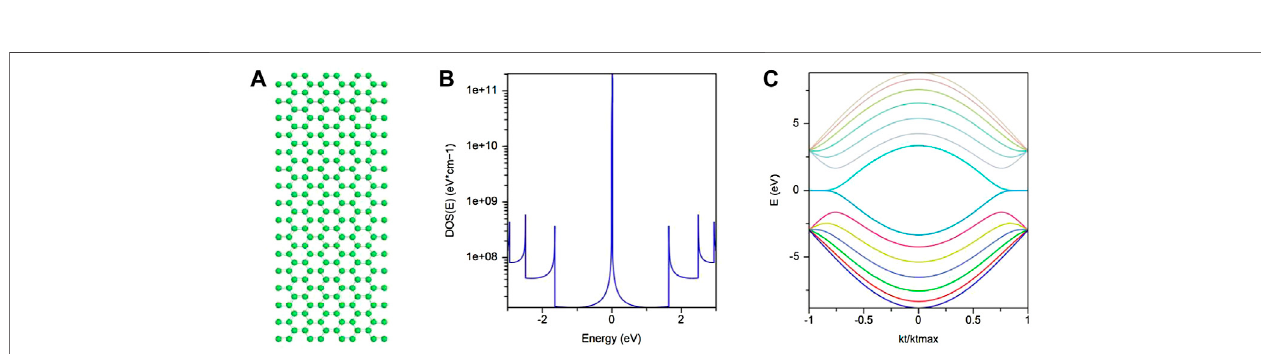
FIGURE 11 | When edge effects are not considered, (A) GNR type-A with tight-binding energy (3 eV), c-c spacing (1.42 A ° ), chirality (7,7), (B) density of state plotted with energy, and (C) band structure. We have plotted these results from the nanohub software of Purdue University [4].